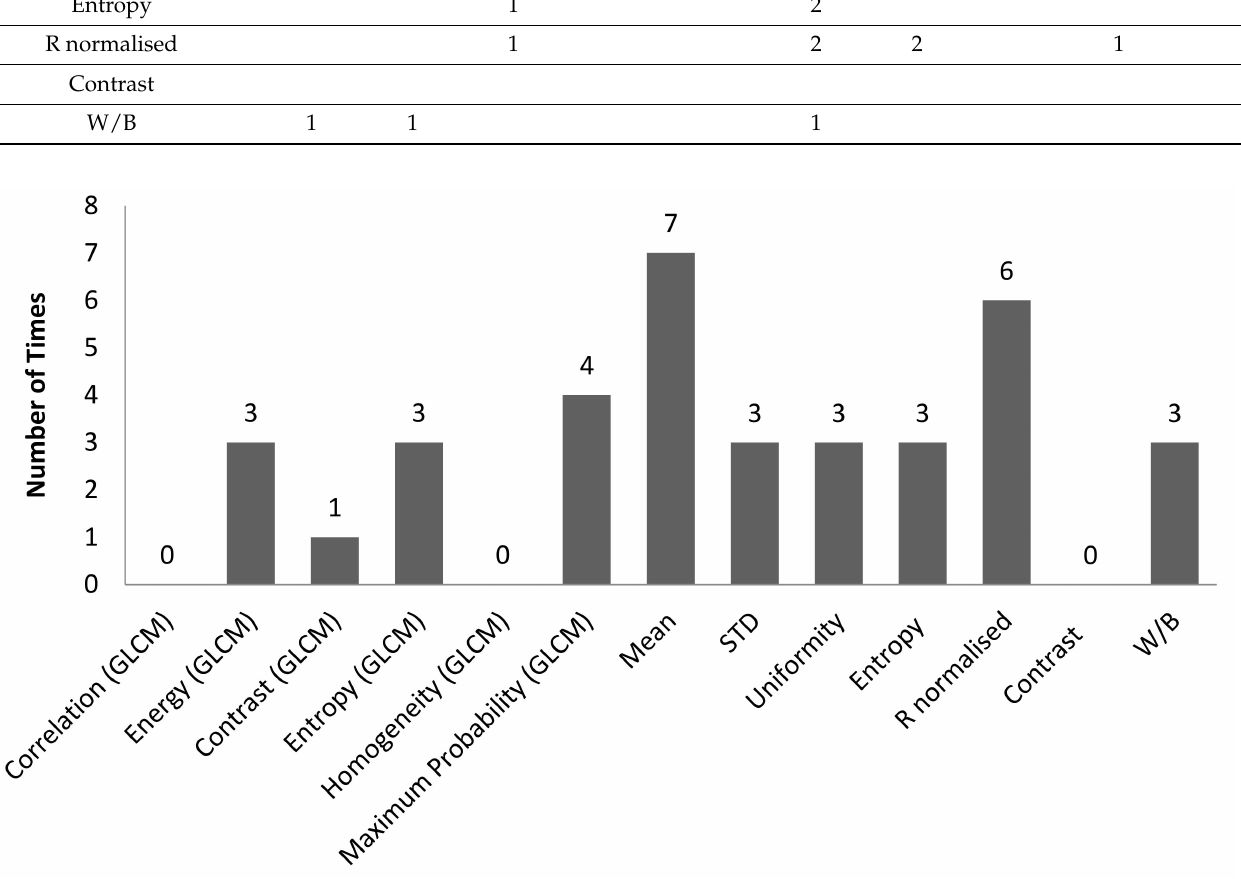
Figure 11. Bar chart showing the number of times a characteristic feature involved in correlation with R 2 ≥ 0.7 for an illumination angle of 45 ◦ for experimental setup